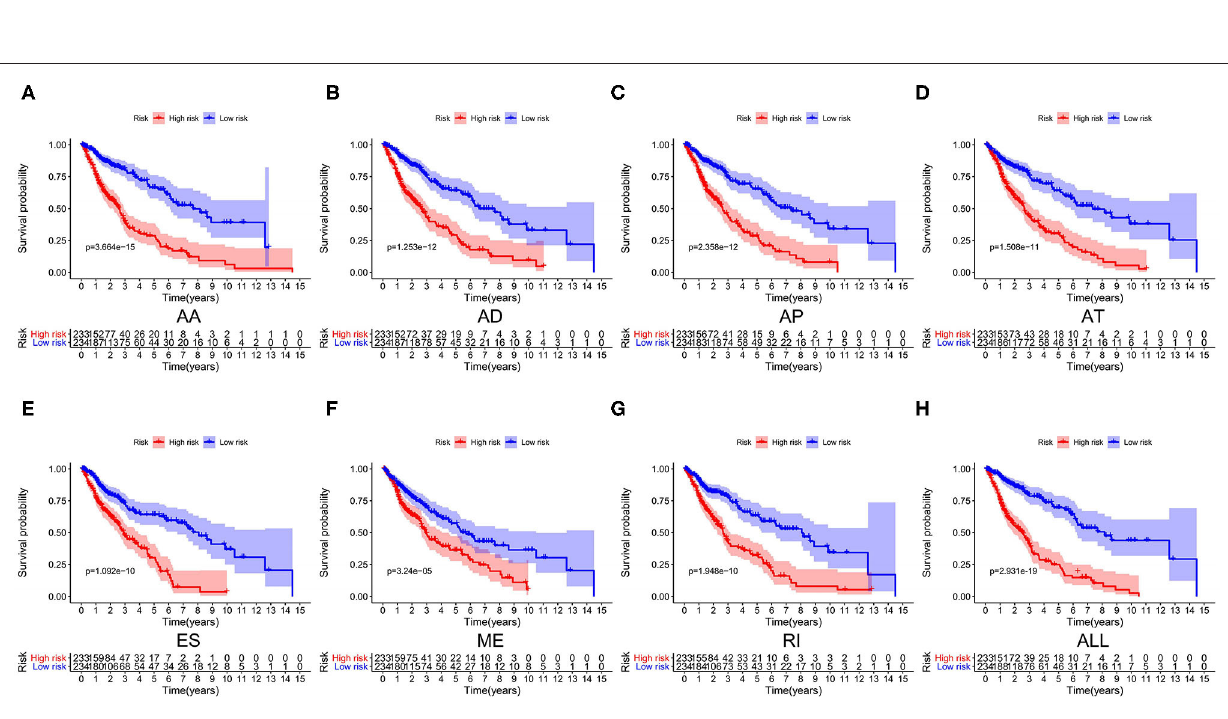
FIGURE 5 | Kaplan–Meier survival analyses of eight prognostic models in LUSC. (A–H) Kaplan–Meier curves of prognostic models constructed with AS events of AA, AD, AP, AT, ES, RI, ME and all splicing types. AA, alternate acceptor site; AD, alternate donor site; AP, alternate promoter; AT, alternate terminator; ES, exon skip; ME, mutually exclusive exons; RI, retained